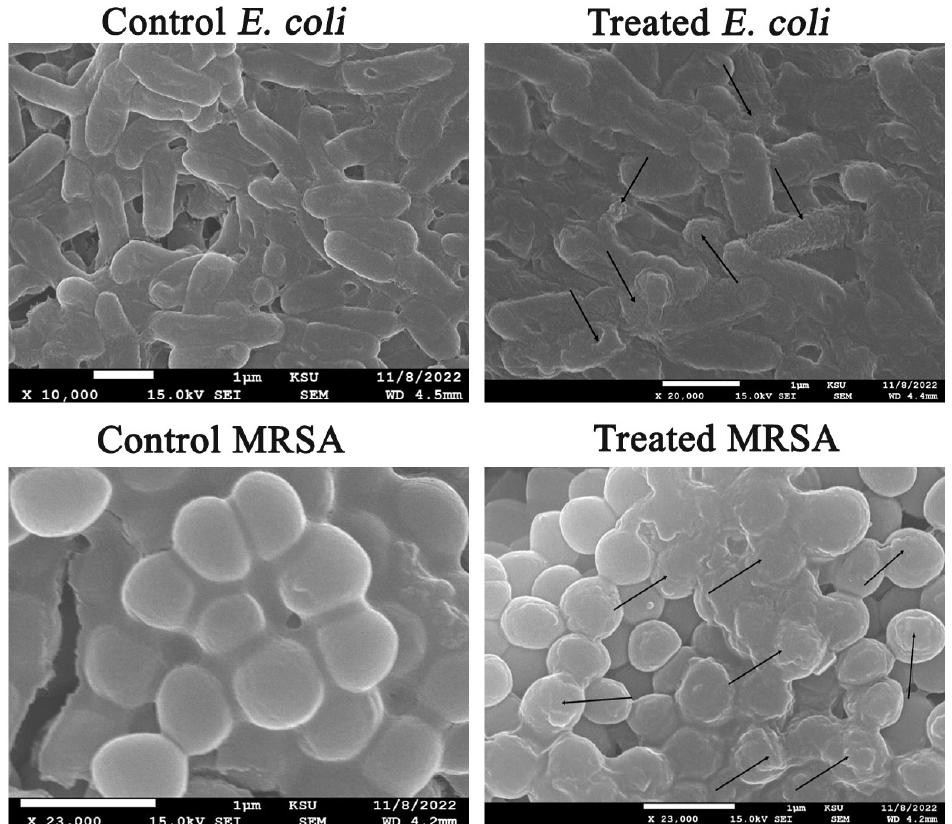
Figure 12. SEM graphs of E. coli and MRSA bacterial cells treated with ZnO-NPs (The deformations of both MRSA and E. coli strains were pointed out by arrows).